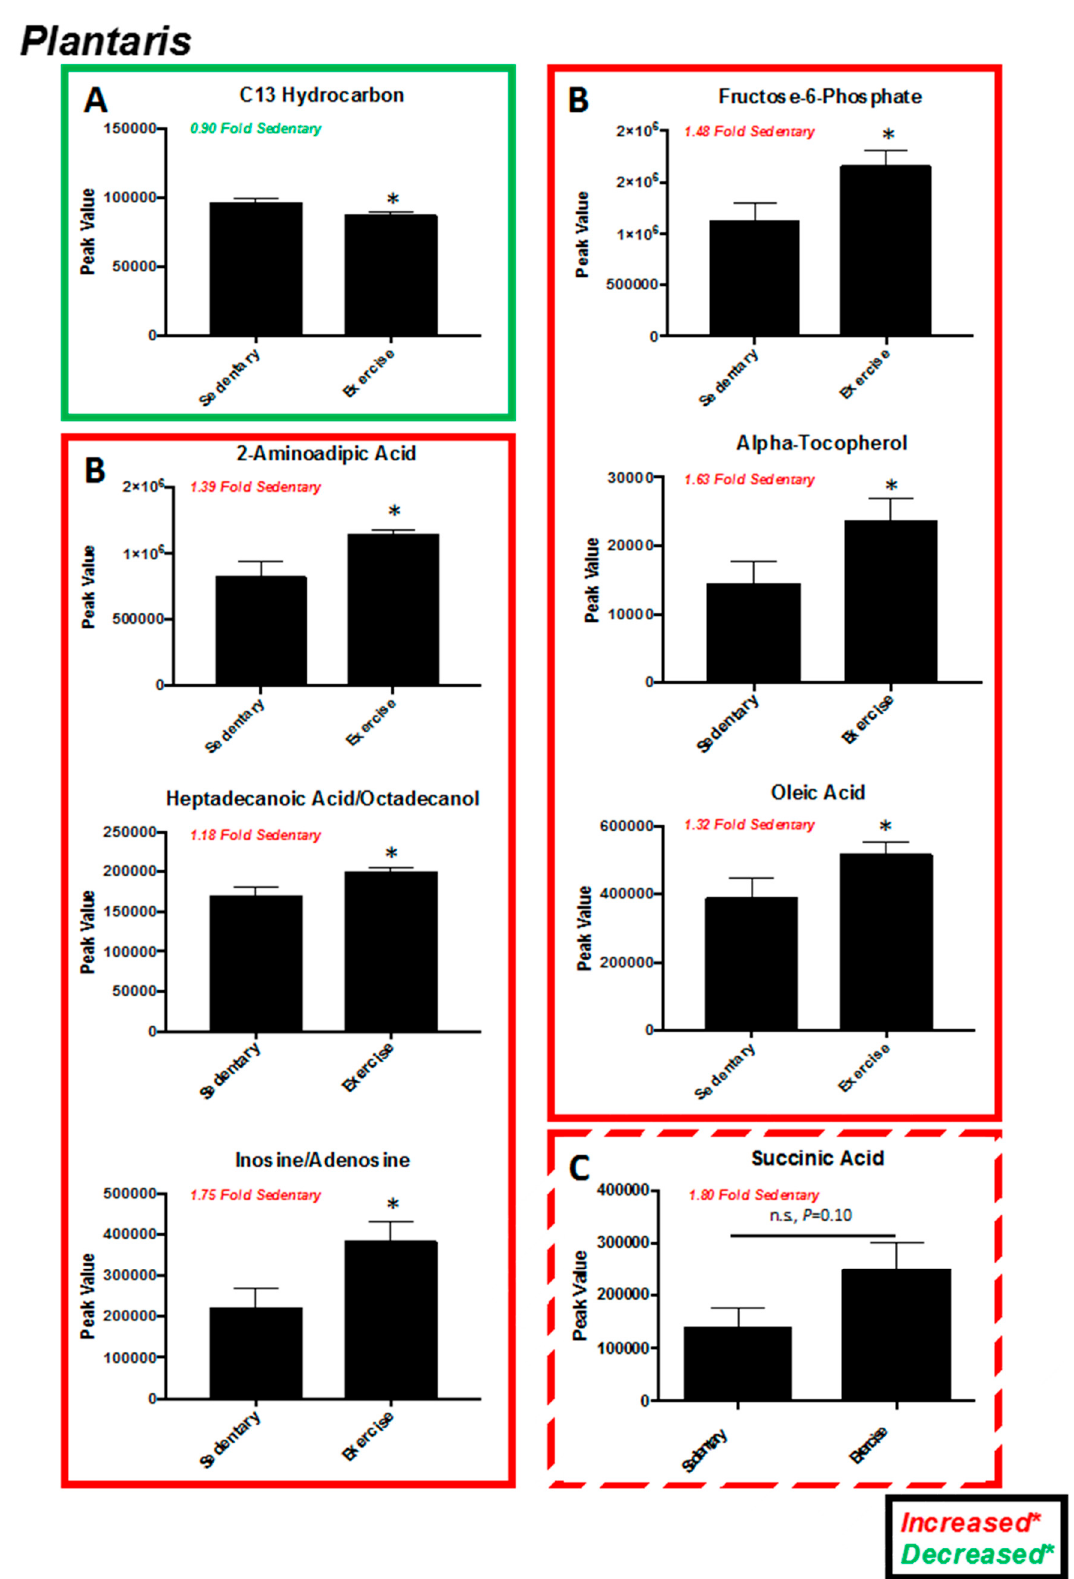
Figure 3. t -Test significant metabolites and succinic acid from plantaris muscle. ( A ) Metabolite decreased in exercise-trained muscle. ( B ) Metabolites increased in exercise-trained muscle. ( C ) Metabolite increased in exercise-trained muscle (not significant). Data represent mean ± SEM. * P < 0.05. N = 12/group.